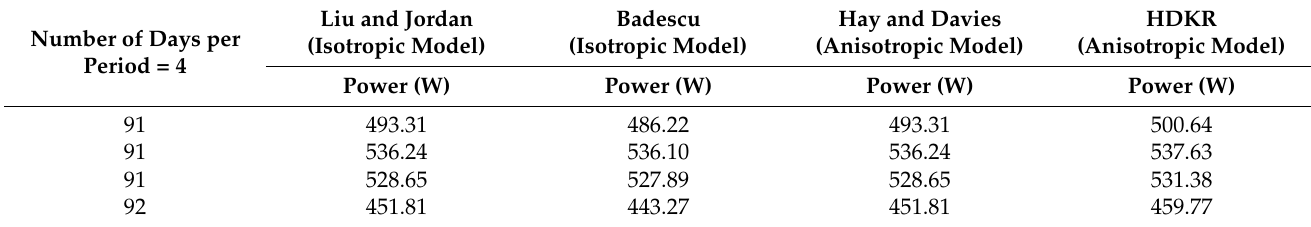
Table 9. Power results for Makkah city for NP =